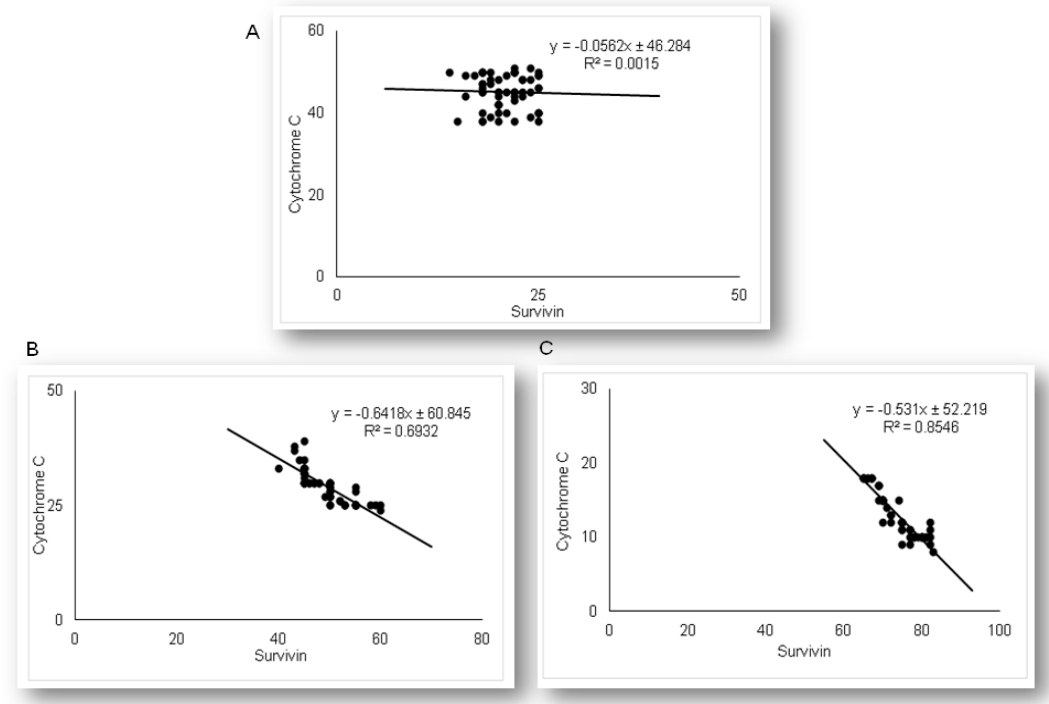
Figure 10. The correlations are shown for survivin and cytochrome C in the renal tubular epithelial cells: ( A ) LPS, ( B ) simvastatin 20 mg/kg group, ( C ) simvastatin 40 mg/kg group.